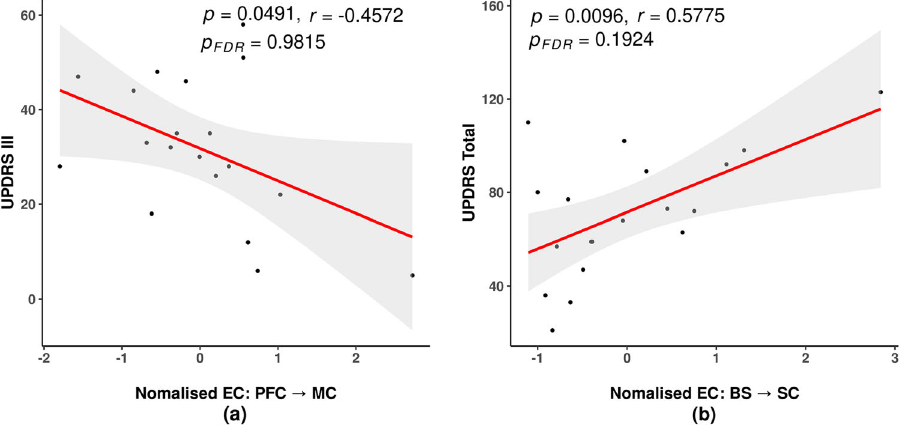
Fig. 5 Correlation between resting-state EC and UPDRS scores in PD patients. a EC: PFC ⇀ MC in relation to UPDRS-III. b Correlation between EC: BS ⇀ SC and UPDRS-Total scores. BS brainstem, CB cerebellum, MC motor cortex, PFC prefrontal cortex, SC subcortical region, EC effective connectivity, UPDRS uni fi ed Parkinson ’ s disease rating scores, FDR false discovery